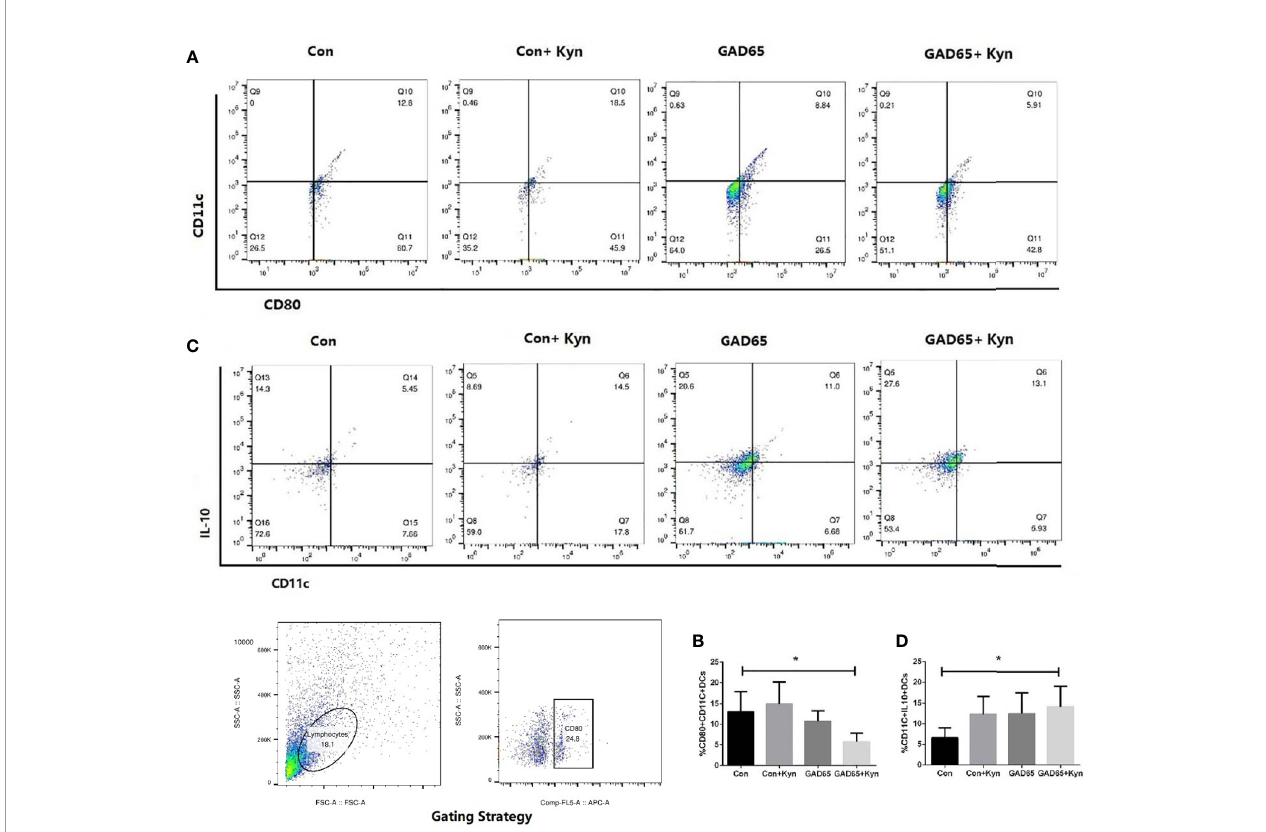
FIGURE 5 | Kyn suppressed mouse dendritic cell maturation. At the 16th week, mice spleen lymphocytes were stained and immediately analyzed on Flow Cytometer. Compared with GAD65 phage vaccine immunization alone, signi fi cantly lower percentages of CD80 + CD11c + DC cells were observed in GAD65 phage vaccine co-immunized with KYN, which suggested that KYN may suppress dendritic cell maturation (A, B) . At the same time, immatured-dendritic cells in the co-immunized group secreted more IL10 than the control group did (C, D) (*P <